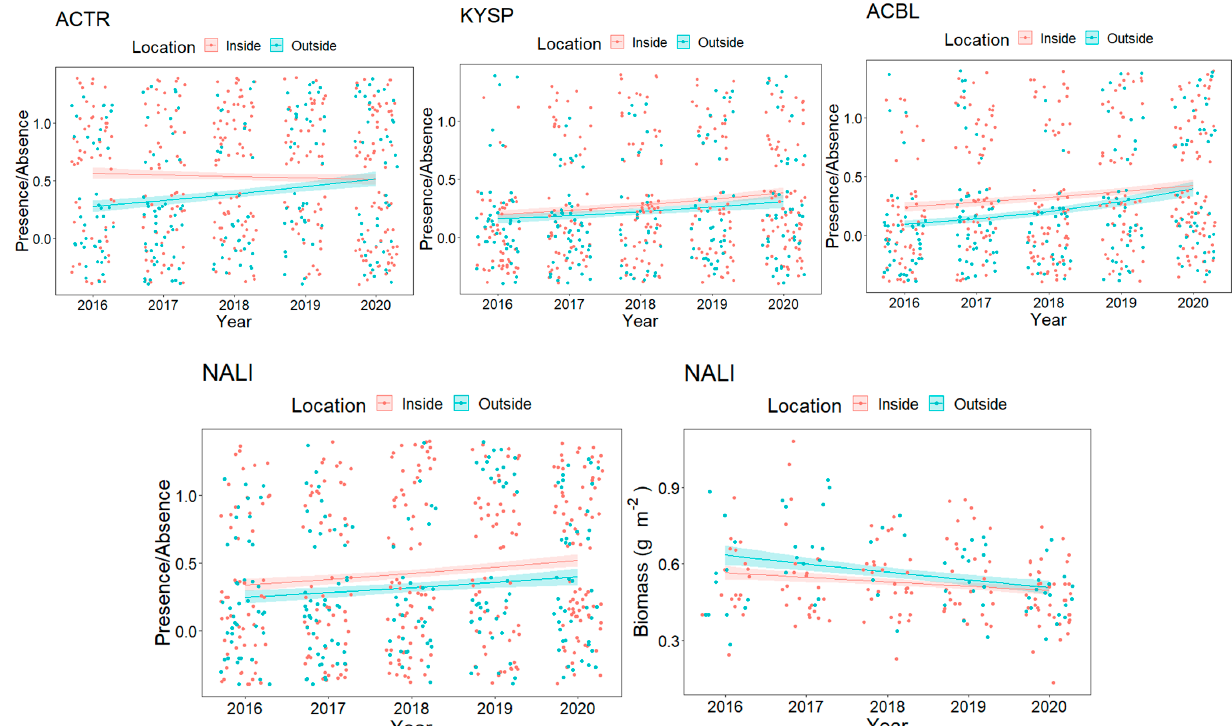
Figure 3. Generalized linear model (GLM) plots of significant trends in both presence/absence and biomass data among locations (ACTR, ACBL, and NALI-presence/absence), years (KYSP, NALI-biomass), and interaction between years and locations (ACTR). Species codes are as follows: A. triostegus (ACTR), A. blochii (ACBL), N. lituratus (NALI), and Kyphosus spp . (KYSP).